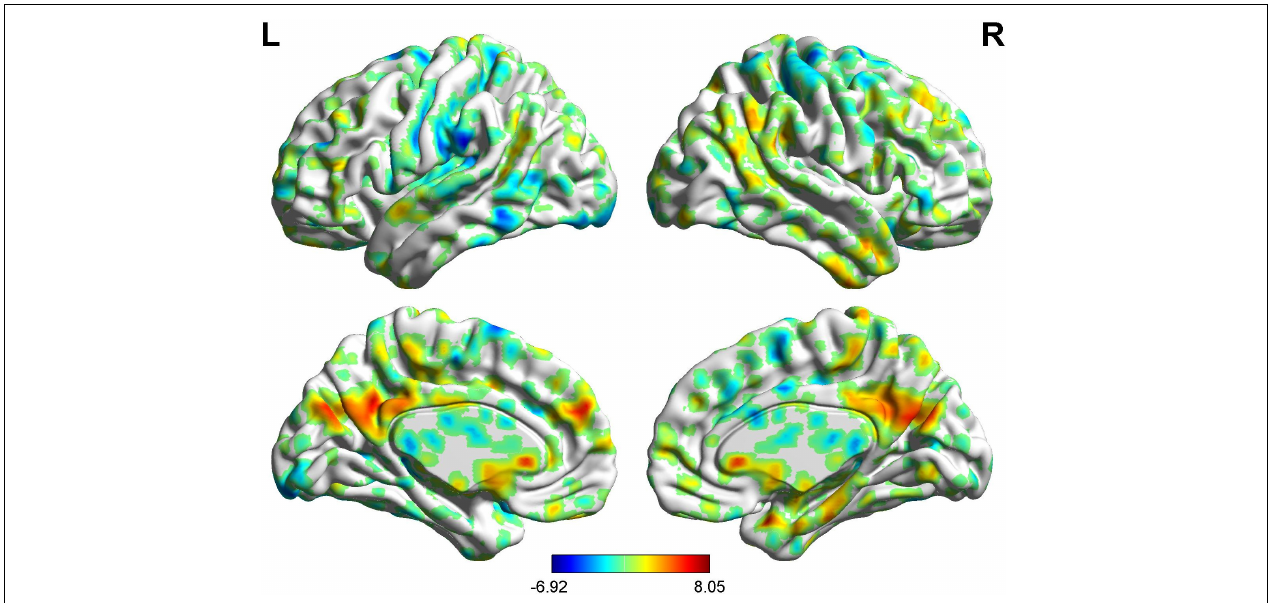
FIGURE 4 | Brain areas showing functional connectivity with the rACC in placebo response in male participants. Color scale represents the Z -score. Red = placebo > pain; blue = pain > placebo.